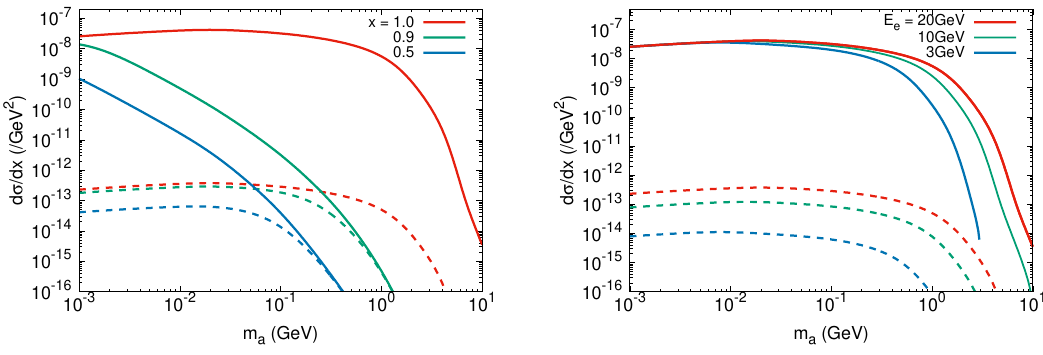
Figure 2 . Differential cross section dσ brems /dx for the scalar interaction. Solid and dashed curves represent the CLFC and CLFV case, respectively, and the coupling constants are taken to be y e = y eµ = y µe = 10 − 6 . Left panel: for x = 1 . 0 (red), 0 . 9 (green), and 0 . 5 (blue), while fixing E e as 20 GeV. Right panel: for E e = 20 (red), 10 (green), and 3 (blue) GeV, while fixing x as 1.0.